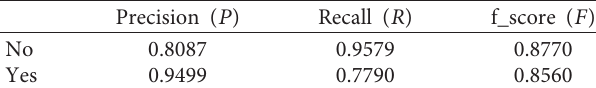
Table 3: DAGRU model player consumption forecast results